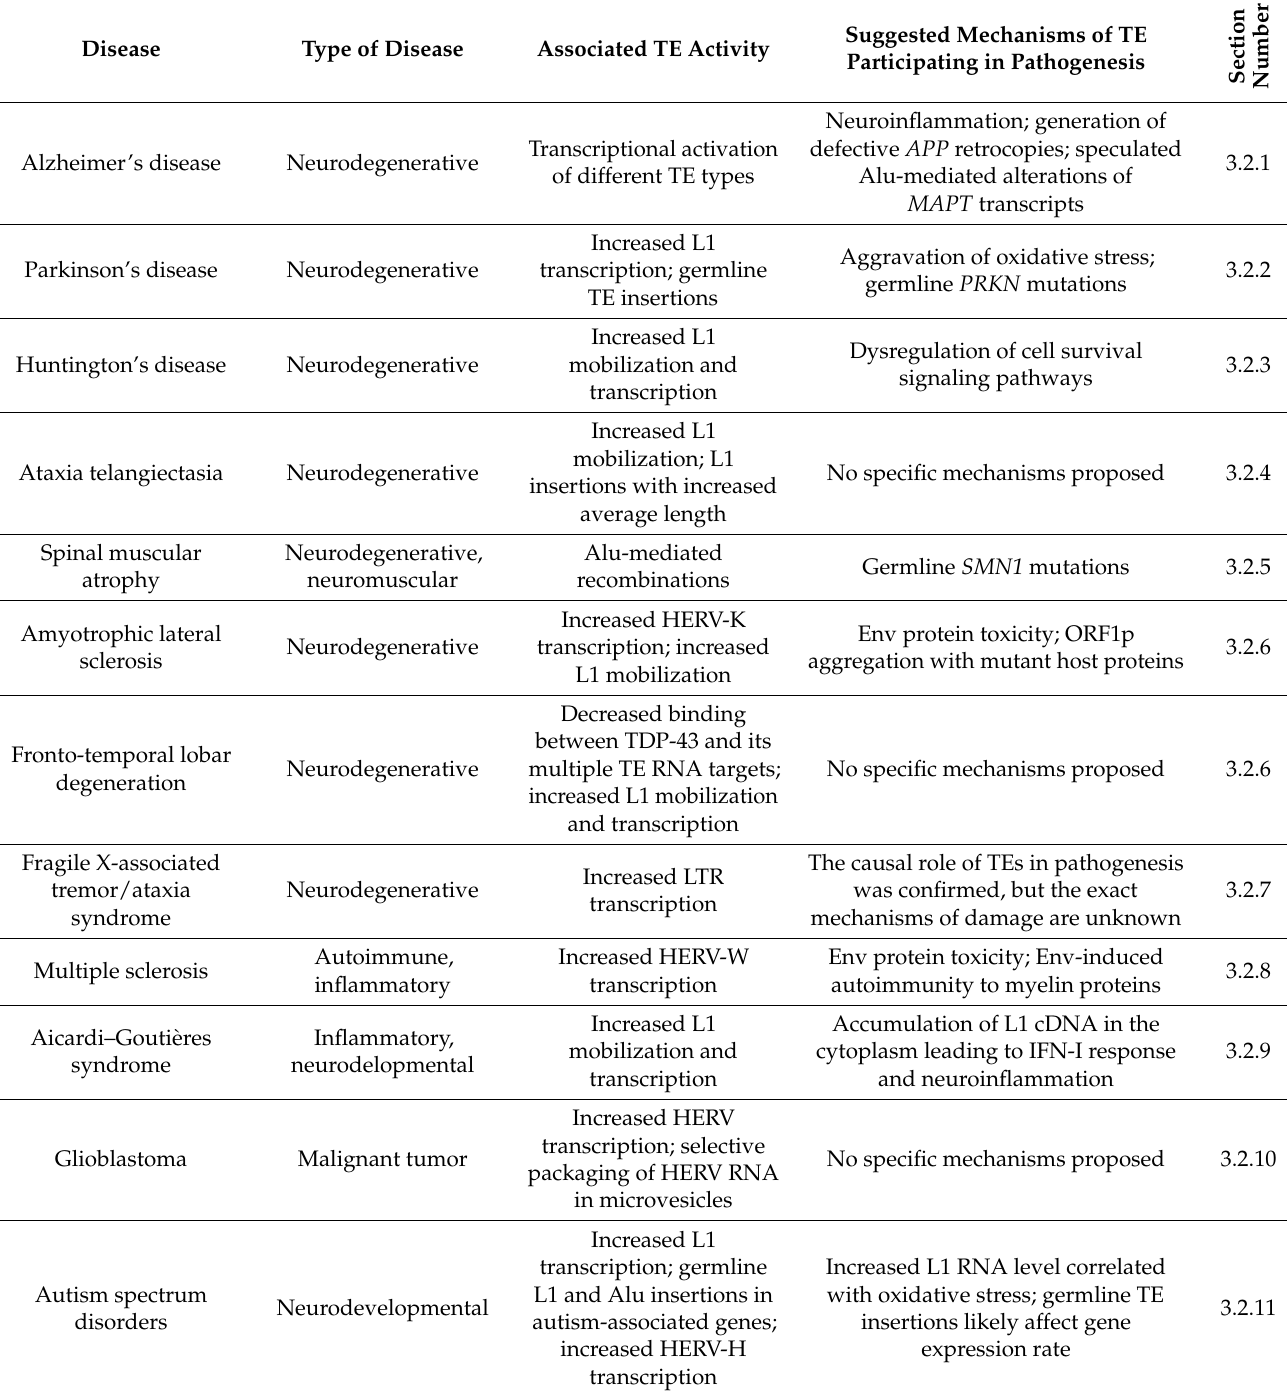
Table 3. Neuropathologies associated with TE